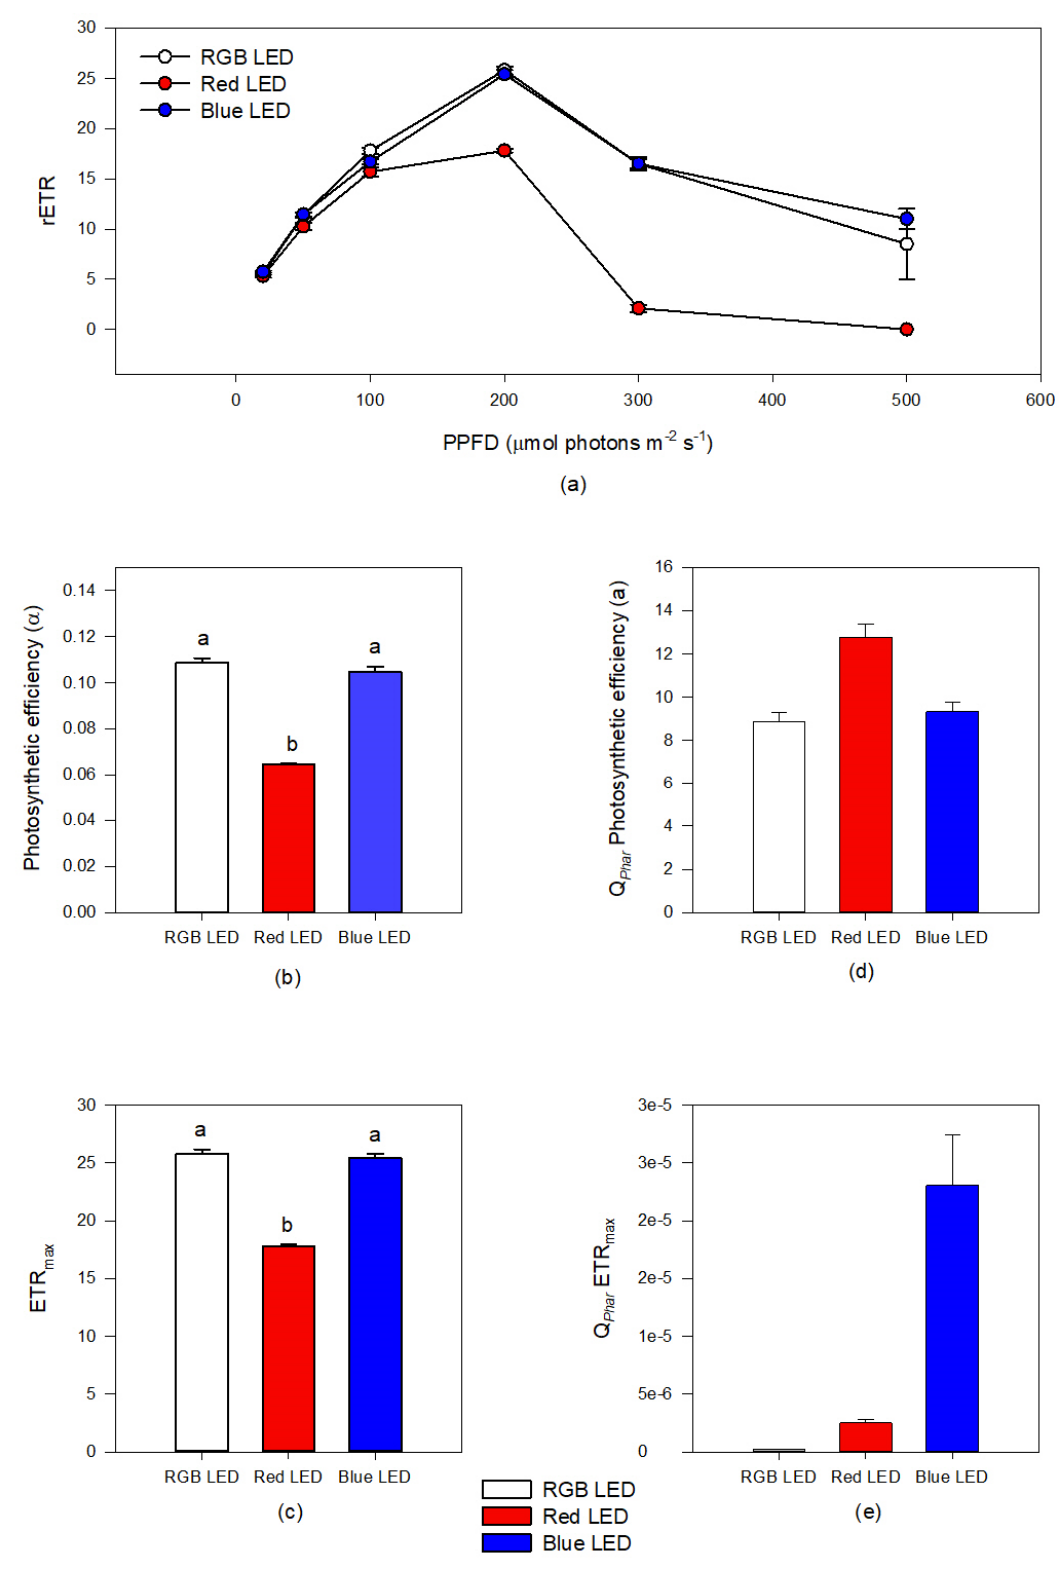
Figure 2. Rapid light curves ( a ), photosynthetic efficiency ( b ) and maximum electron transport rate (( c ), ETR max ) based on incident photosynthetic photon flux density (PPFD) and in the pigment weighted light absorption (( d ), Q Phar photosynthetic efficiency; ( e ), maximum electron transport rate Q Phar ETR max ) in P. tricornutum cultures ( N = 5) subjected to the three light treatments at the end of the 96 h exposure period (average ± standard error, letters denote significant differences between light treatments at p < 0.05).